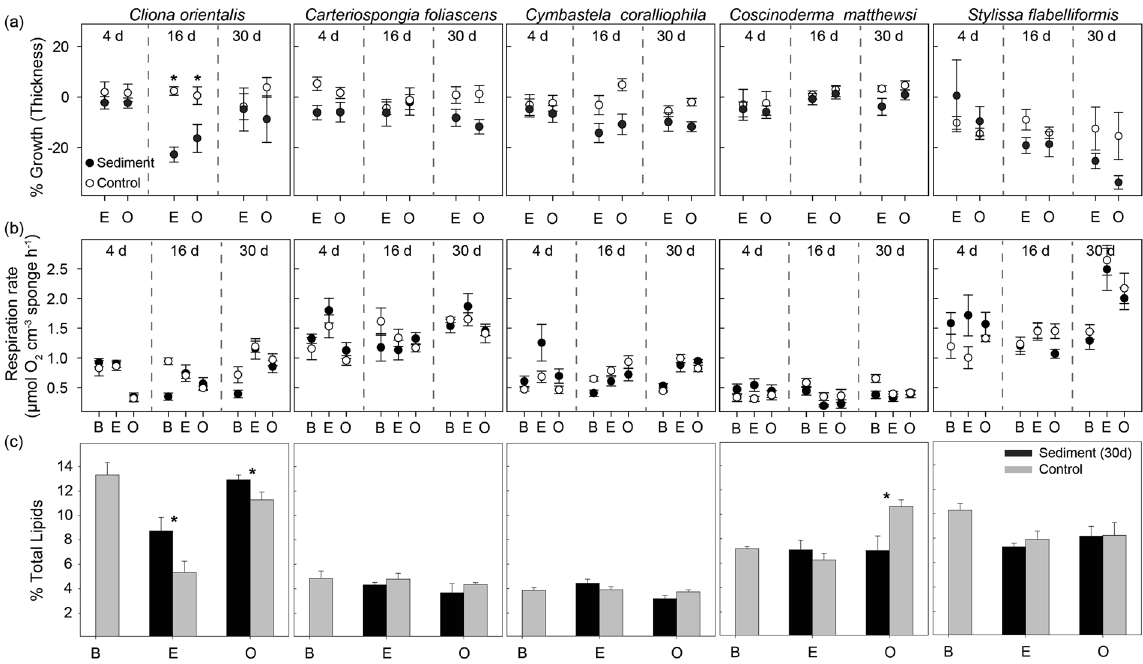
Figure 2. Physiological responses of sponges to sediment smothering. ( a ) Percentage of growth (based on sponge thickness), ( b ) Mean respiration rates ( µ mol O 2 cm − 3 sponge h − 1 ) for all species and treatments (control vs. smothered for 4, 16 or 30 d), ( c ) Percentage of sponge biomass comprised of lipids, for all species exposed for 30 d, where ‘B’ is before sediment addition, ‘E’ is after the exposure period and ‘O’ is at the end of the observational phase. All data are mean ± SE and asterisks show statistically significant differences between smothered and control sponges (t-tests: P <